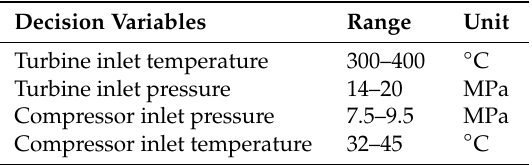
Table 5. Set of decision variables and their range of